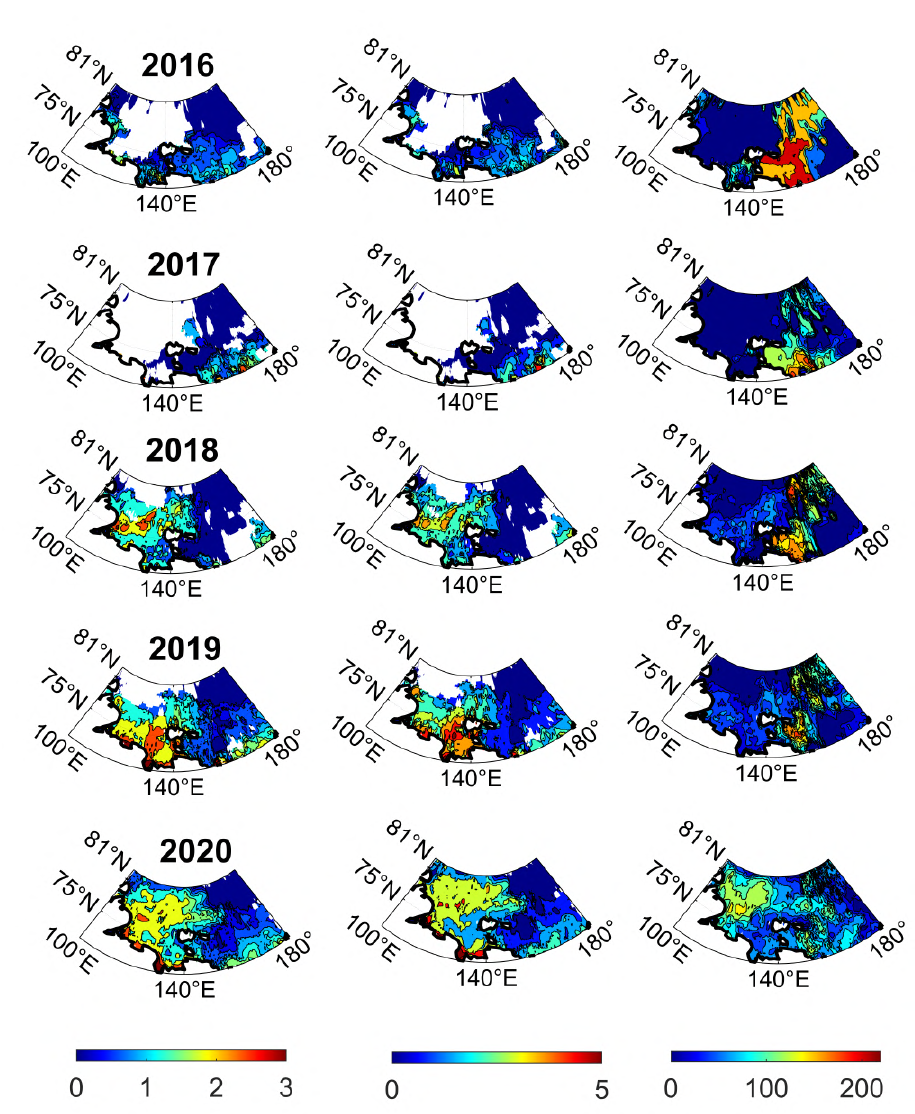
Figure 7. MHWs after climate trend elimination in the Laptev and East Siberian seas in 2016–2020. Left column shows annual mean intensity (in ◦ C), central column—annual maximum intensity (in ◦ C), right column—total duration (in days) of the MHW during the year. Tendency analysis in the mean and maximum intensity and total duration of MHWs shows (Figure 8) that in general, the area in which the presence or absence of a trend is observed with certainty (within 95% confidence interval) has decreased compared to the previous analysis. The MHW intensity (both mean and maximum) grows in the vicinity of the Taimyr Peninsula at a rate of 0.15–0.20 ◦ C/year. This area includes the eastern part of the Kara Sea and the deep and coastal parts west of the Laptev Sea. Comparing Figure 3a,b and Figure 8a,b, we note that, in contrast to the previous analysis, there is no reliable trend in the whole shallow part of the Laptev Sea, except for the coastal line of the western part. This fact suggests that the temperature rise in this area has a long-term character. In remote areas of this sea, short-term changes become more intense in the region of 75–80 ◦ N. Their intensity grows here at a rate of 0.10–0.15 ◦